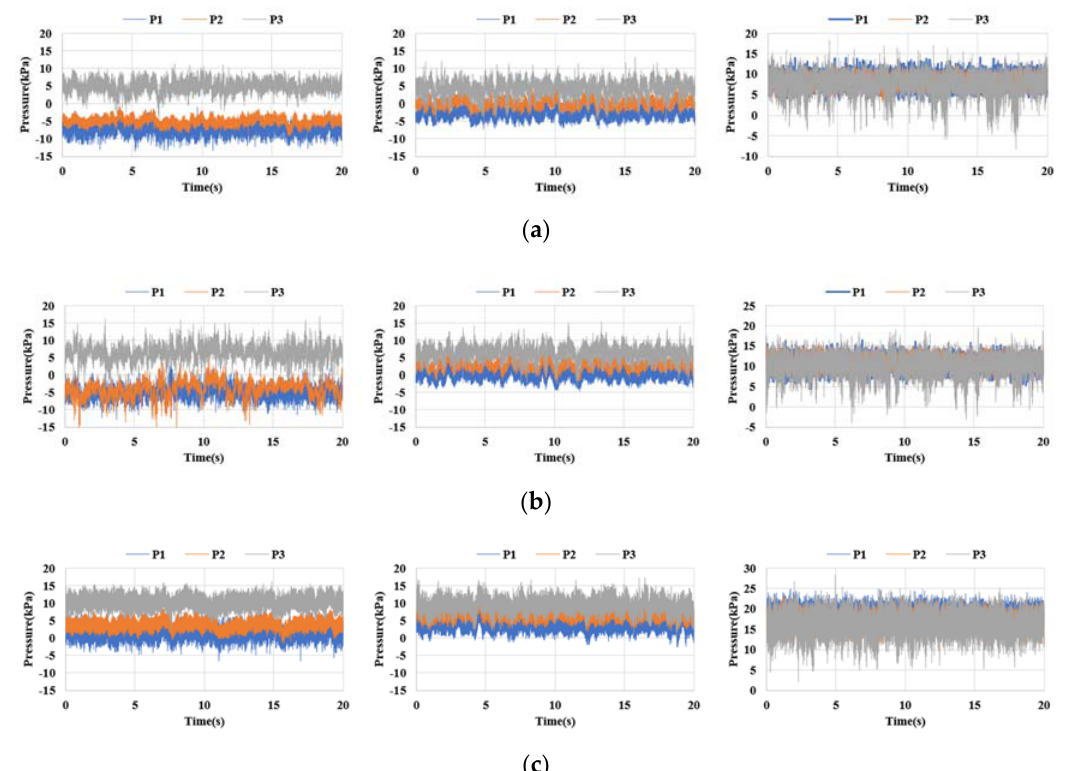
Figure 9. Time domain of pressure pulsations for three schemes at different conditions: ( a ) H min = 3.5m; ( b ) H d = 4.7 m; ( c ) H max = 6.5 m (each row from left to right is H = 204 mm, 164 mm and 142 mm).